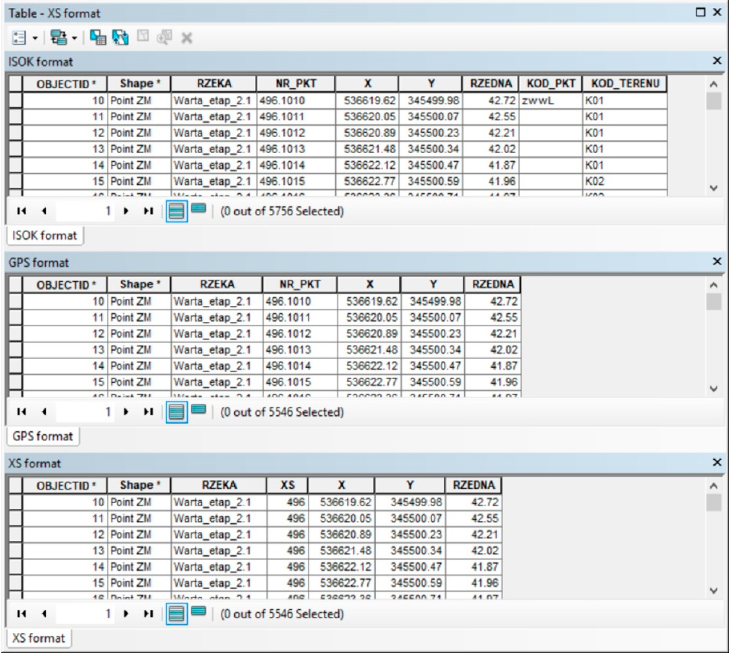
Figure 4. Example of required data: tables of attributes for measurement points.